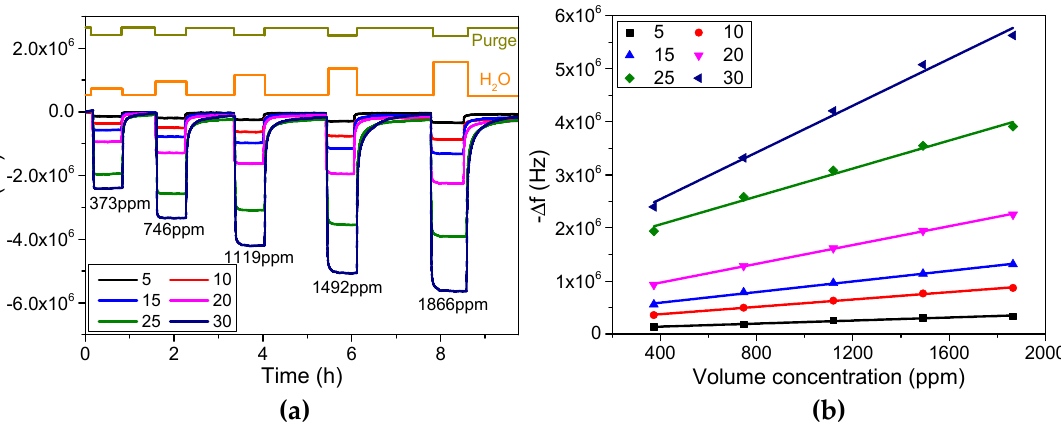
Figure 7. Humidity sensing via PET-coated FBAR. ( a ) Real-time responses of FBARs with the volume concentration of water vapor changing from 373 ppm to 1866 ppm. The number of PSS/PDDA bilayers ranges from 5 to 30; ( b ) frequency shift with respect to the various volume concentration of water vapor and number of PSS/PDDA bilayers. Table 2. Sensitivity and linearity of FBARs coated with various number of PSS/PDDA bilayers with the volume concentration of water vapor changing from 373 ppm to 1866 ppm.